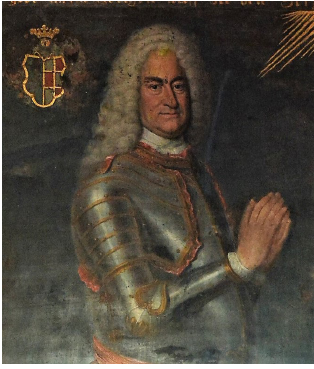
Figure 3 Portrait of Schack von